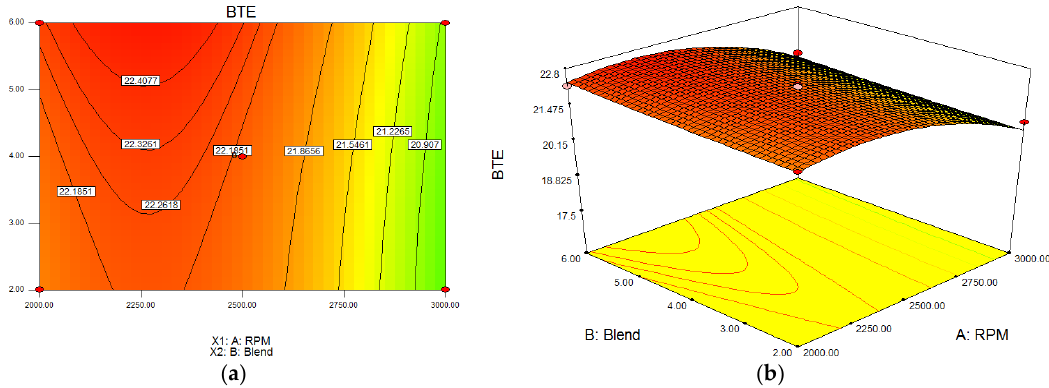
Figure 12. The interactive effect biodiesel and engine speed on the BSFC. ( a ) 2D contour plots; and ( b ) 3D response surface plot.